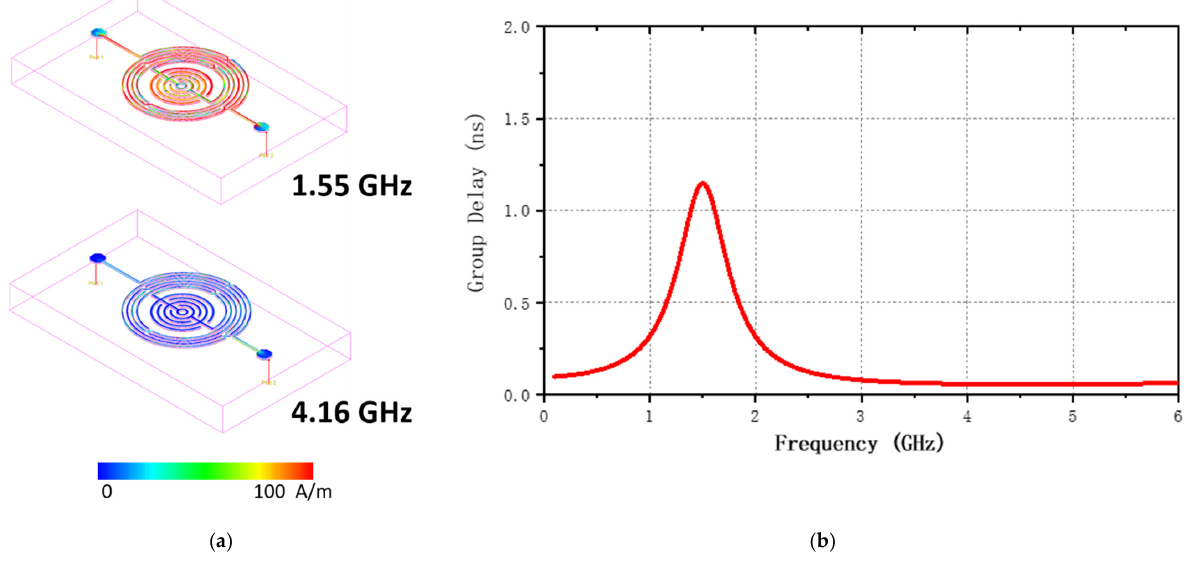
Figure 4. Results of optimization: ( a ) current densities of the passband and stopband; and ( b ) group delay.